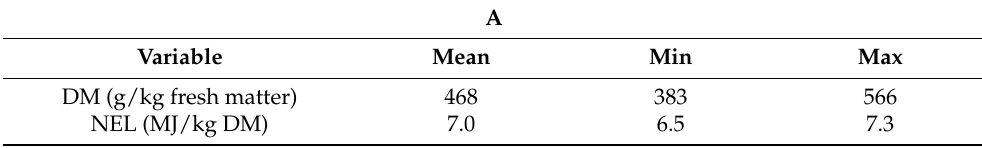
Table 3. Mean, minimal, and maximal contents of dry matter (DM), net energy for lactation (NEL), organic matter (OM), crude protein (CP), ash-free acid detergent fiber (ADFom), and ash-free neutral detergent fiber (aNDFom) in the rations fed (A) as well as mean, minimal, and maximal proportions of feedstuffs in the diets